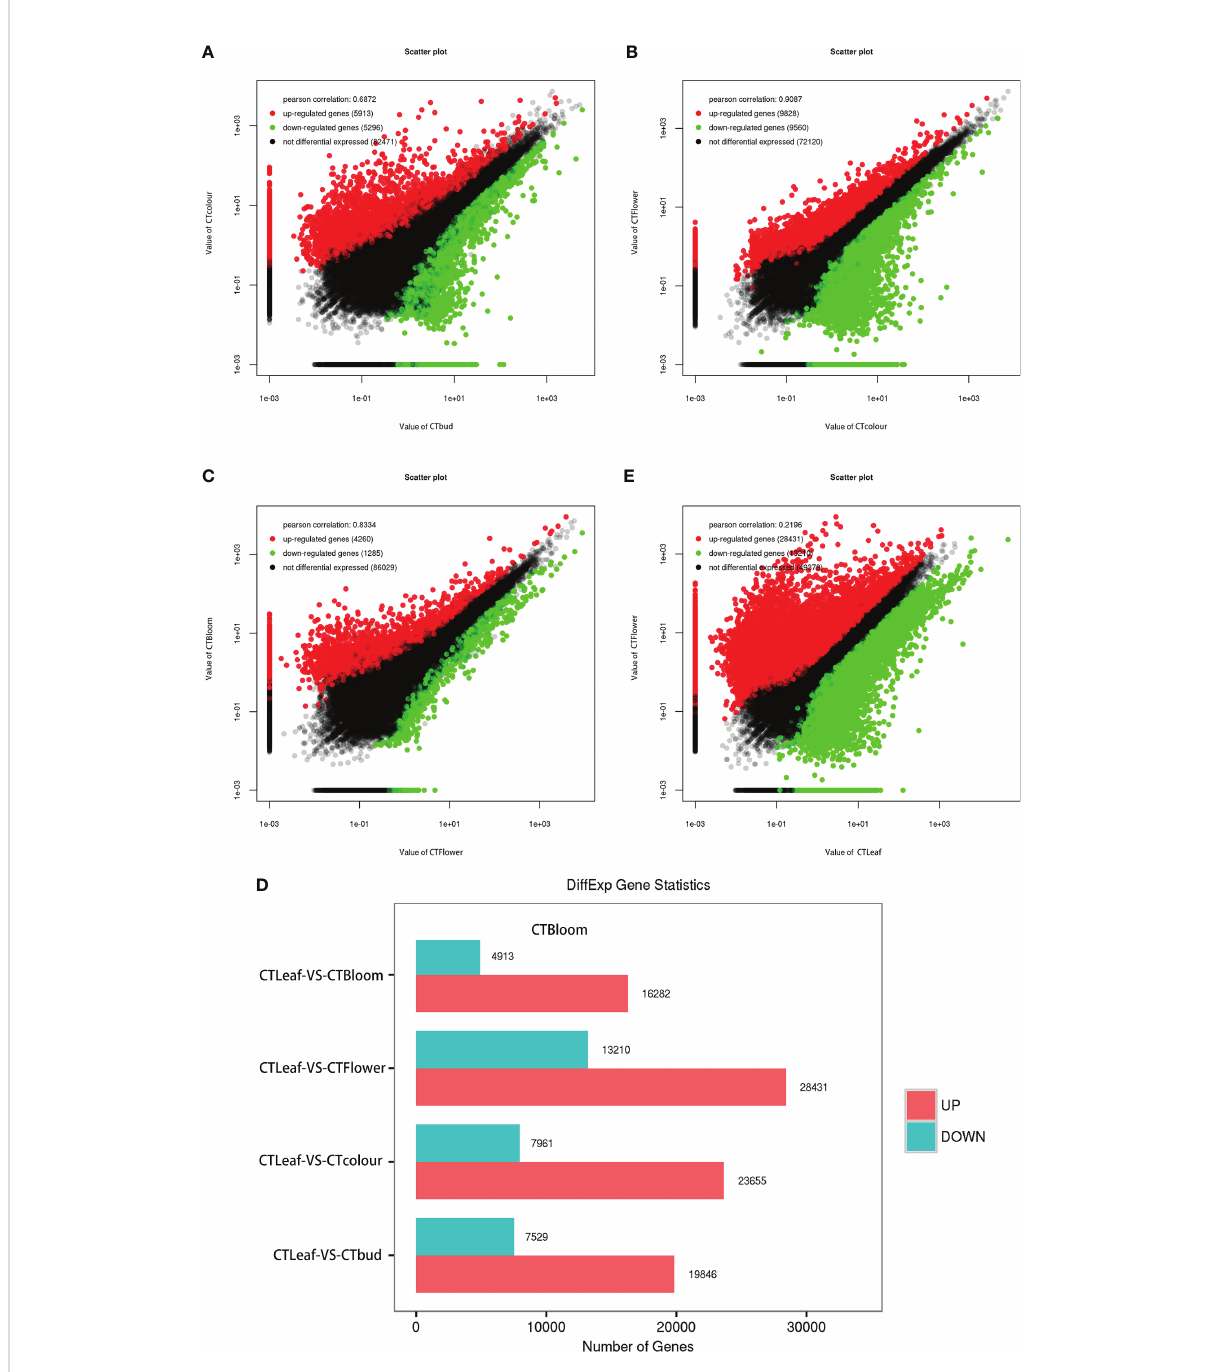
FIGURE 4 Differentially expressed genes in the leaves, buds, and in fl orescences of O. longilobus . (A) Scatter plot of the up-regulated and down-regulated genes detected by the comparison between the buds and in fl orescences at the exposure stage. (B) Scatter plot of the up-regulated and down- regulated genes detected by the comparison between the in fl orescences at the exposure and initial opening stages. (C) Scatter plot of the up- regulated and down-regulated genes detected by the comparison between the in fl orescences at the initial opening and blooming stages. (D) Changes in the expression of the DEGs between the leaves and the buds as well as the in fl orescences at the exposure, initial opening, and blooming stages. (E) Scatter plot of the up-regulated and down-regulated genes detected by the comparison between the leaves and the in fl orescences at the initial opening